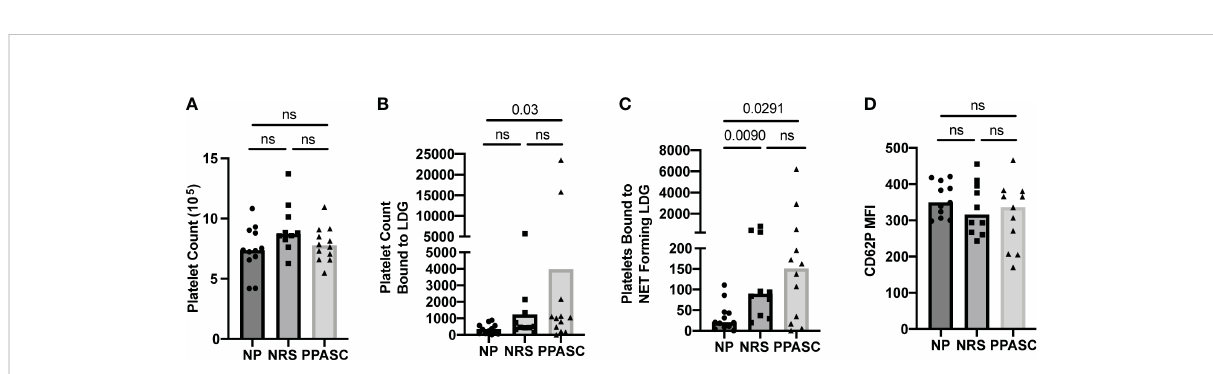
FIGURE 6 Total number of platelets (A) , bound to LDGs (B) , bound to NET forming LDGs (C) , and MFI of CD62P on platelet bound to NET forming LDGs in NP, NRS, and PPASC (D) . Graphs are shown as bar with scatter dot plots. Comparisons between groups were performed using Mann-Whitney U test. ns, non-signi fi cant, p > 0.05.